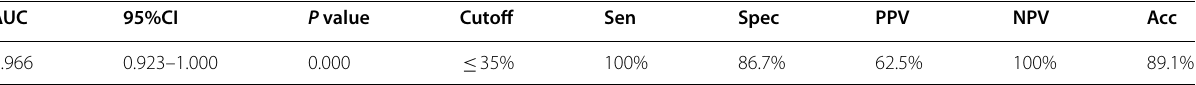
Table 10 ROC curve analysis in differentiating molecular type A from other molecular types through Ki67 value AUC